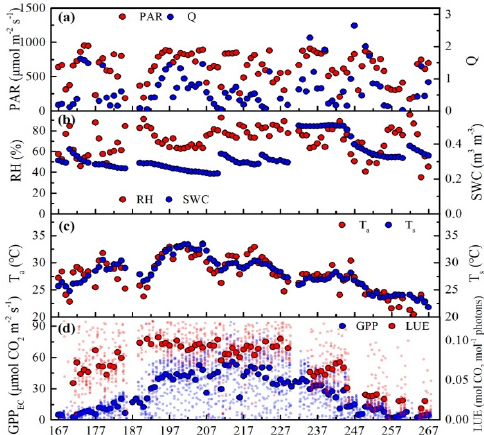
Figure 5. Seasonal variations of the daily mean ( a ) photosynthetically active radiation (PAR) and sky condition (Q), ( b ) relative humidity (RH), and soil water content (SWC), ( c ) air temperature (T a ) and soil temperature (T s ), and ( d ) GPP EC and LUE EC . Daily means were calculated from half-hourly values from 6:00 to 18:00 in the day. Small dot indicates half-hourly GPP EC